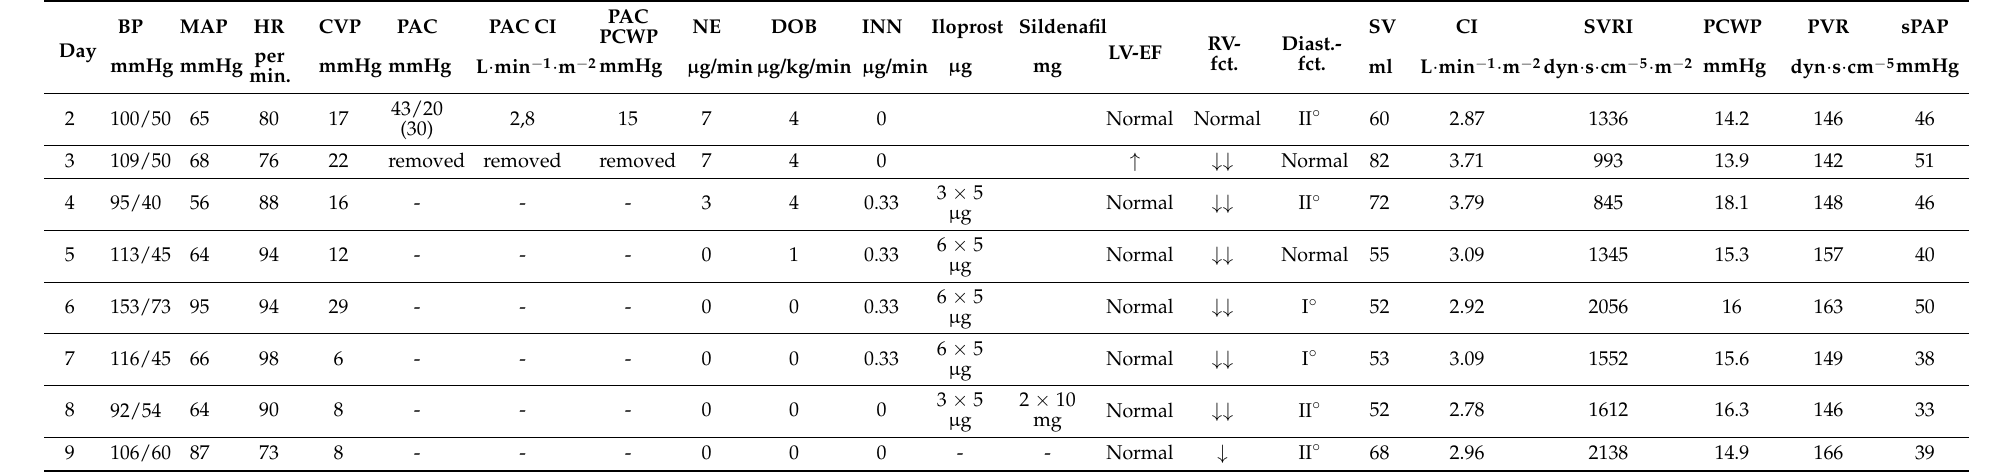
Table 2. Haemodynamics and vasoactive and inotropic drug therapy after heart transplantation in patient